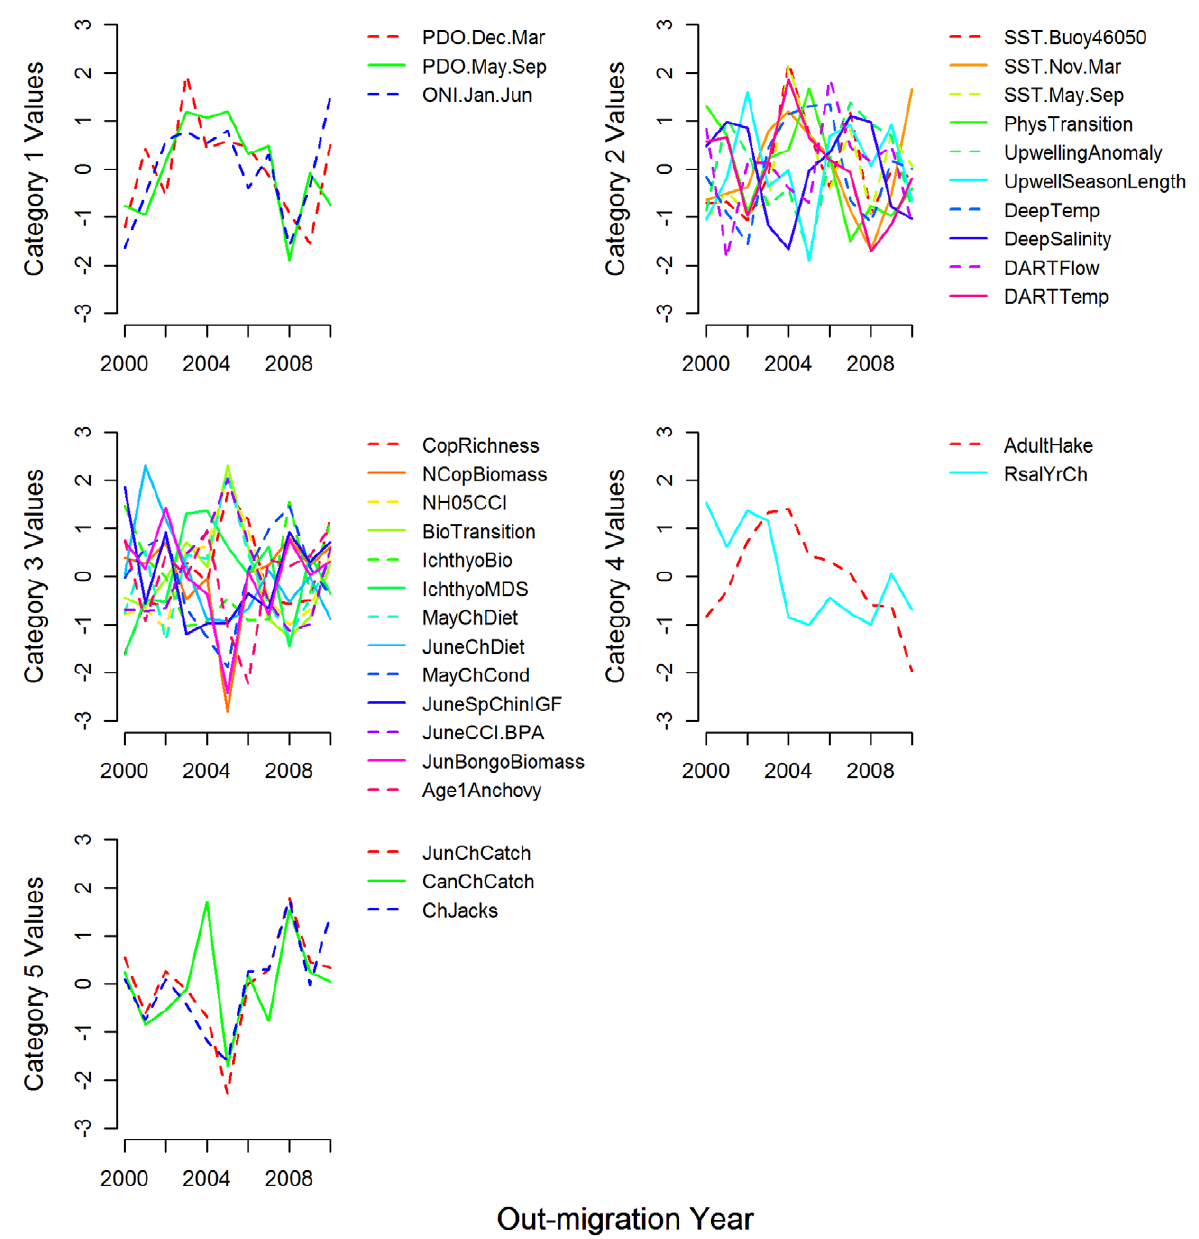
Figure 2. Time series of the 31 indicators, organized by category. All indicator data were scaled to have a mean of 0 and a standard deviation of 1. Indicator categories include 1) large-scale oceanic and atmospheric, 2) local and regional physical, 3) growth/feeding, 4) predation/disease, and 5) cohort abundance.